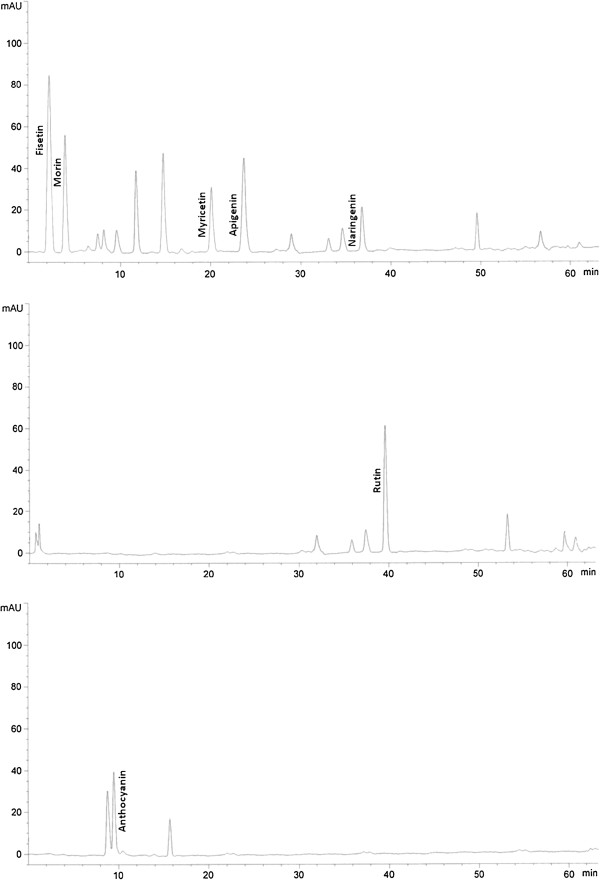
HPLC chromatogram of leaf extracts of H. Bara ginger treated with 10-3M SA and kept under elevated CO2condition (800 μmol·mol-1CO2).